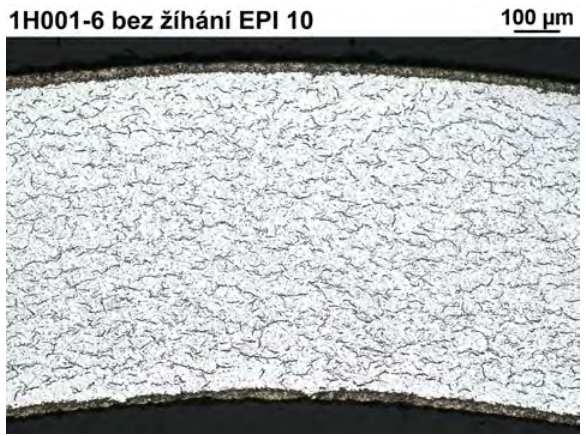
Figure 7. Sample 1H001, section 6. Prepared after hydrogen charging (without annealing).